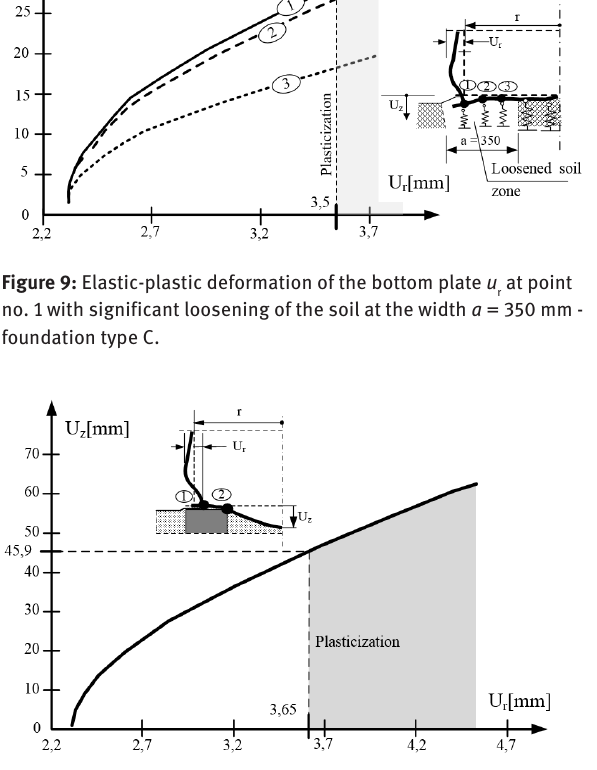
Figure 10: Elastic-plastic deformation of bottom plates u 2, when settling in the form of a trough (fig. 2a) – foundation type